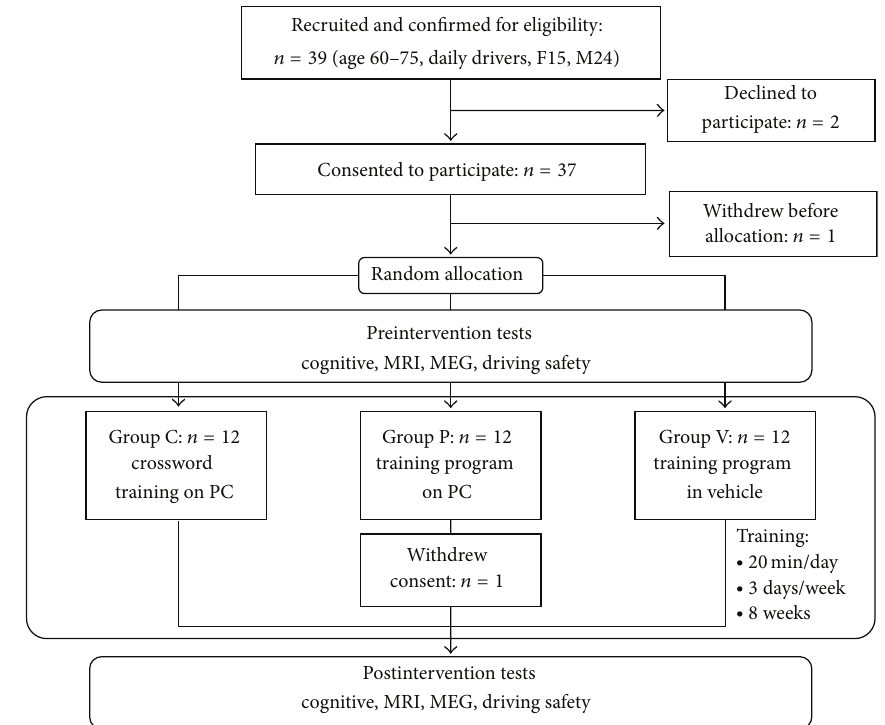
Figure 1: Flow diagram of this